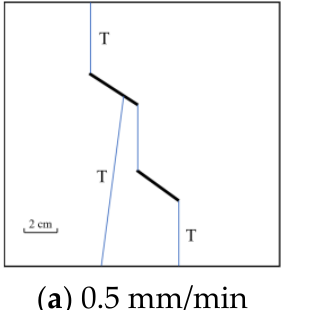
Figure 5. Crack propagation mode diagram of crack test under uniform loading.